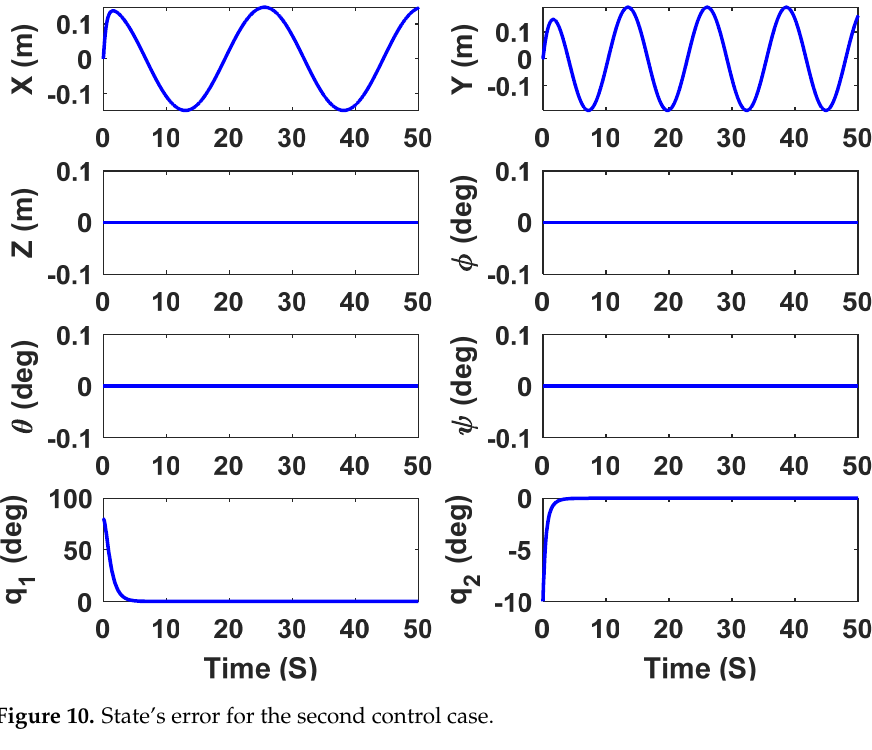
Figure 10. State’s error for the second control case.